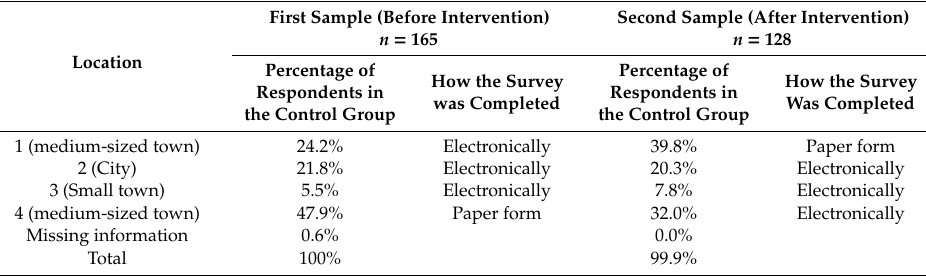
Table 4. The regional distribution of the control group